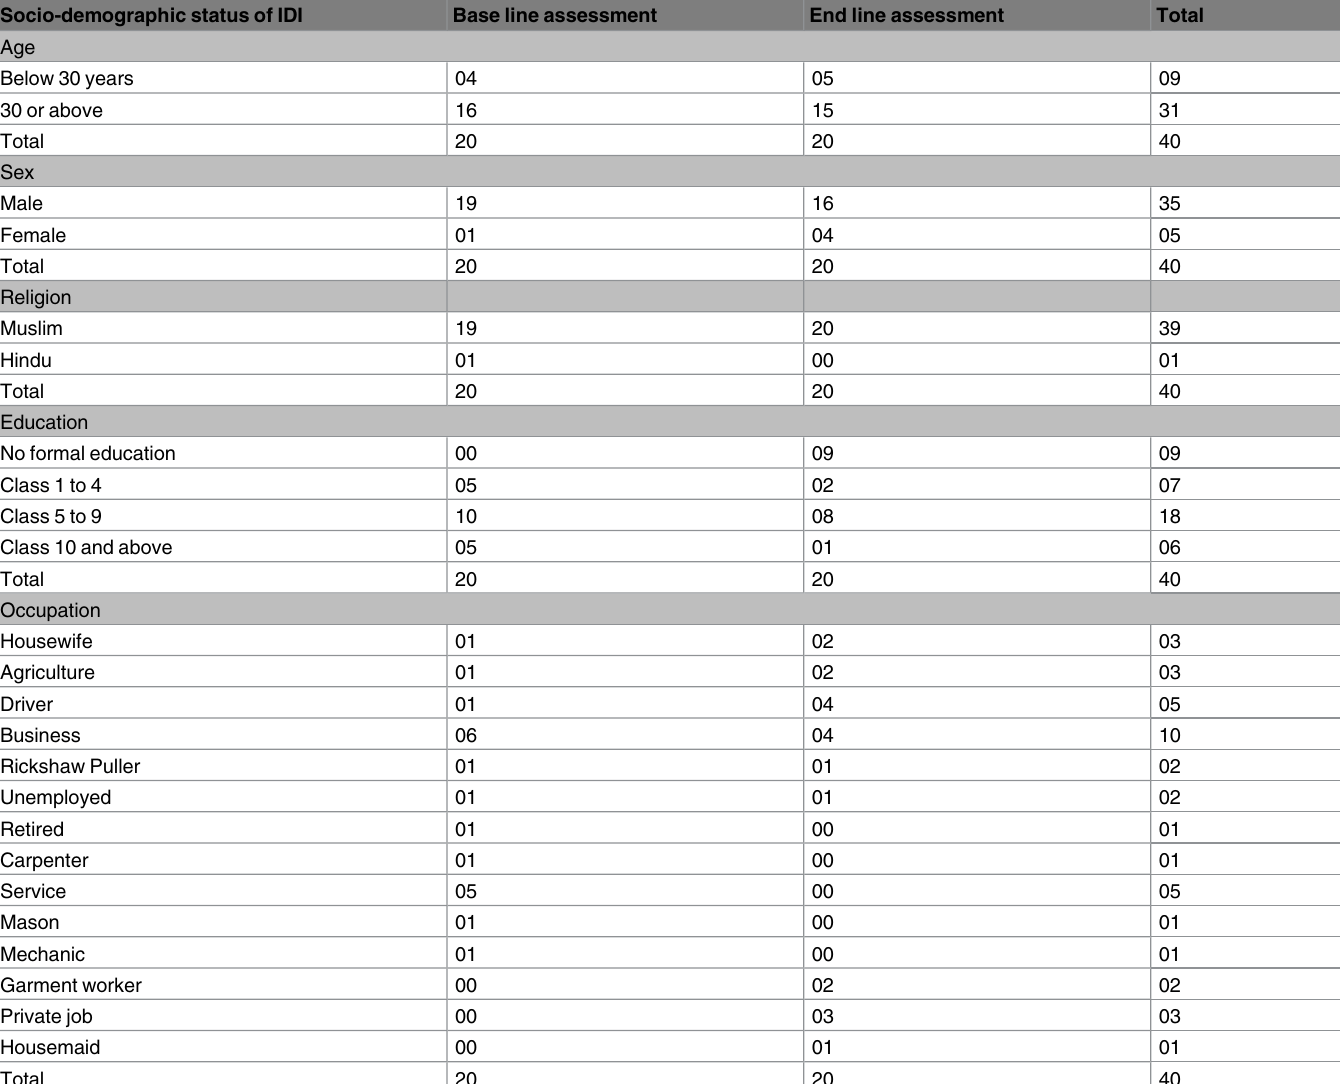
Table 3. Socio-demographic information of IDI